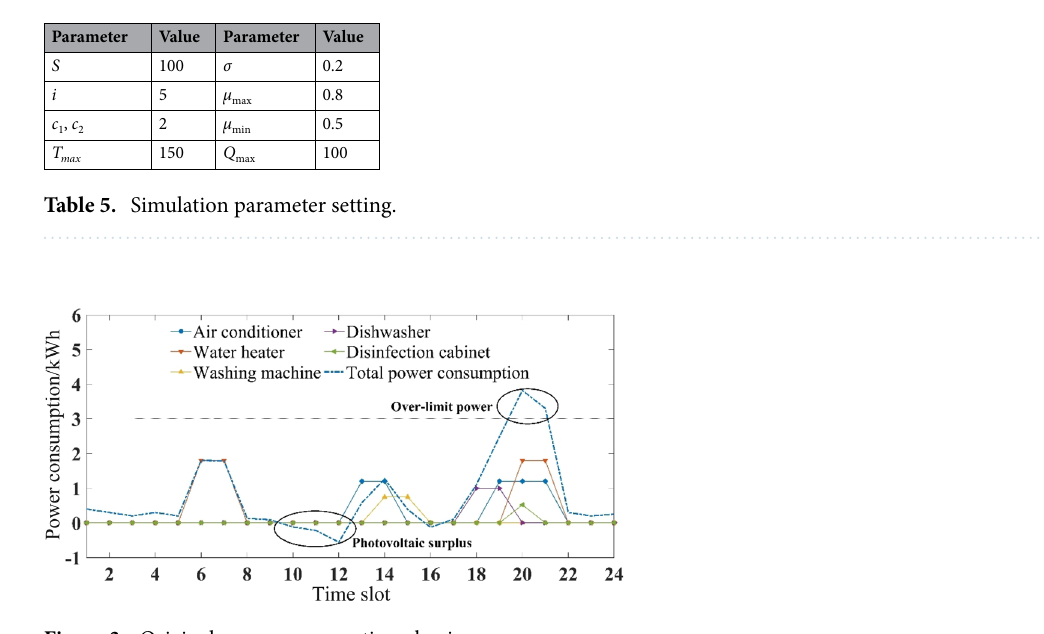
Figure 3. Original power consumption plan in